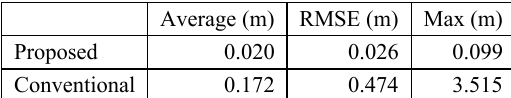
Table 5 . Statistics of the accuracy of